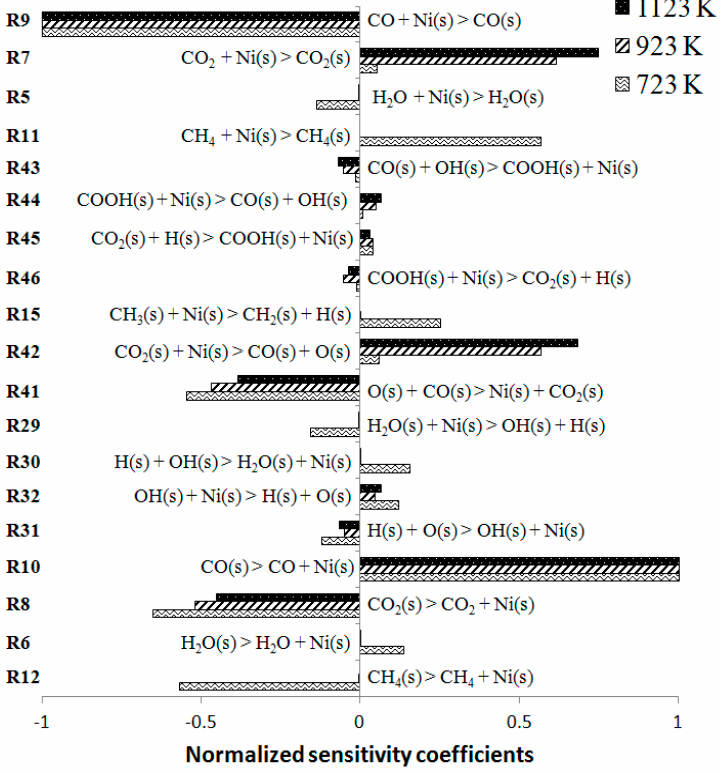
Figure 8. Reaction flow analysis for steam reforming of methane on nickel at 823 K, 1 bar, and a ratio of CH 4 /H 2 O = 0.8.